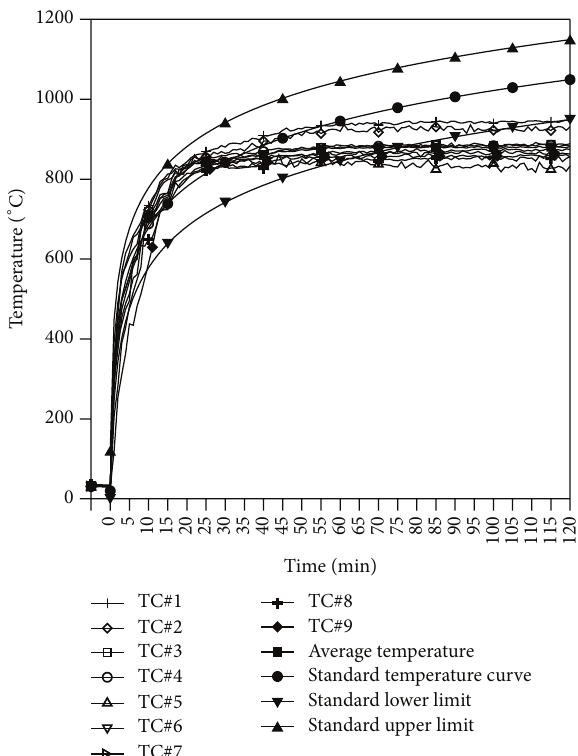
Figure 11: Temperature distributions of the interior furnace (water film on the exposed surface).